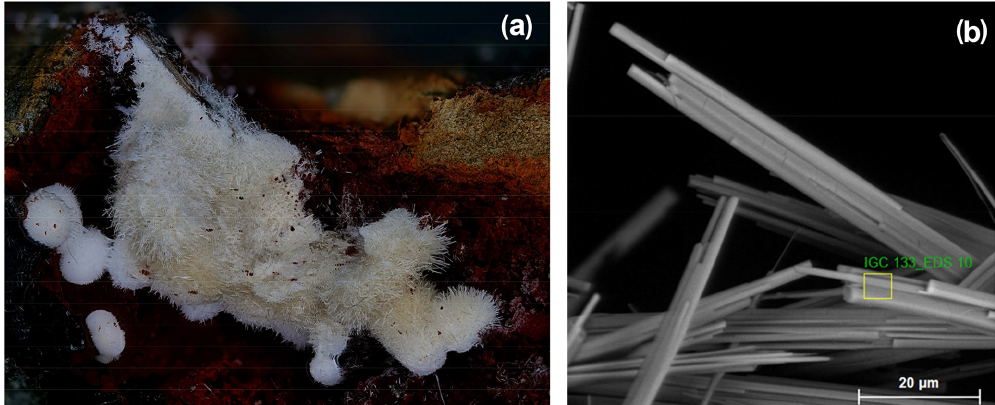
Figure 2. (a) Clusters of white needles of allanpringite/strunzite in specimen IGC133 (FOV = 4.9mm). (b) Characteristic form of crystals, showing central strunzite needle with epitaxial allanpringite needles on either side.